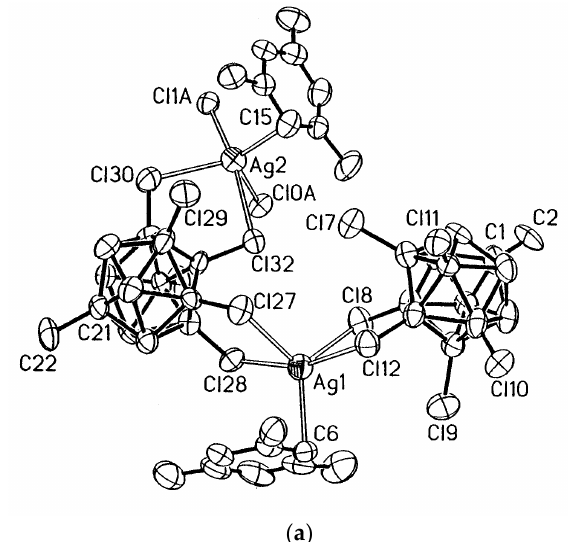
Figure 71. Cont. Figure 71.